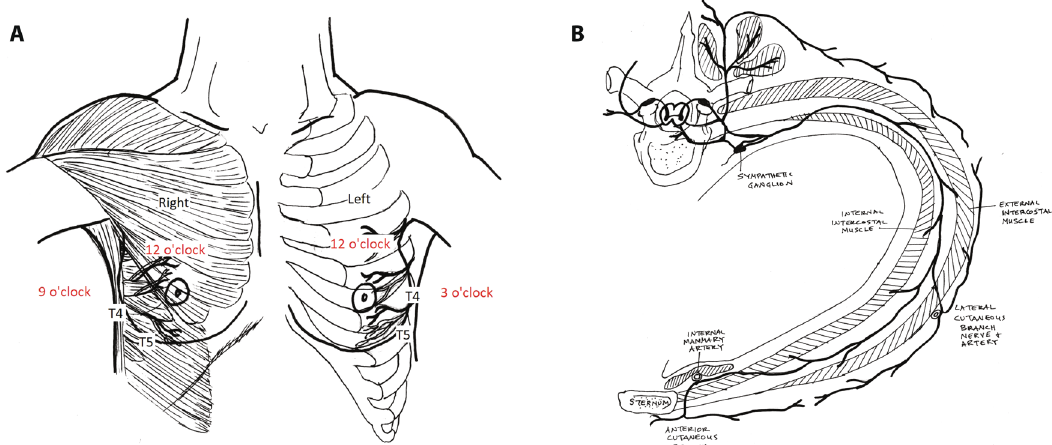
Fig. 2 Anatomy of trigger point injections for post-mastectomy pain syndrome. a Trigger point locations. The patient is placed in the supine position and the breast (native or reconstructed) is lifted or retracted. The area just above the inframammary fold is examined, by palpating the rib, then fi rm pressure is maintained against the chest wall from the IMF cranially over a span of 4 cm. b Path of the cutaneous branches of T4 and T5 nerves as they exit the chest wall. Credit for illustrations: Flora Varghese (co-author),